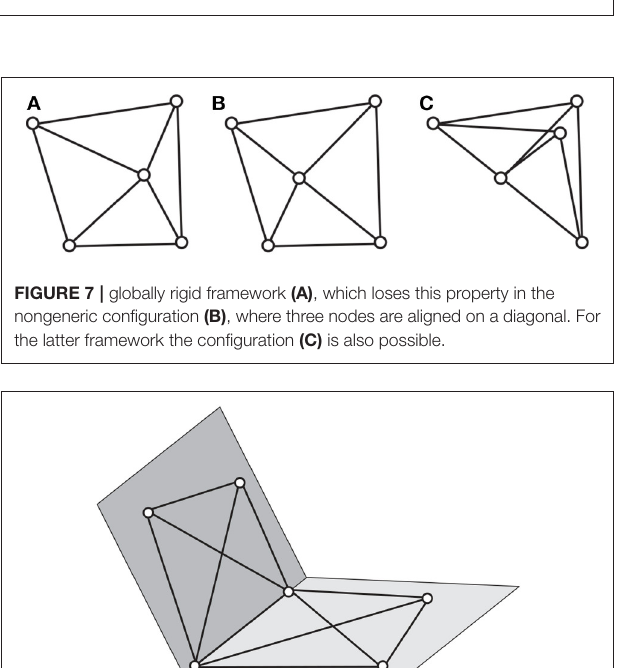
FIGURE 5 | The rigid frameworks (A) , in two dimensions, and (D) , in three dimensions, are not globally rigid: there exist more than one non-congruent admissible configurations, for example, (B,C) for (A) , and (E) for (D) .